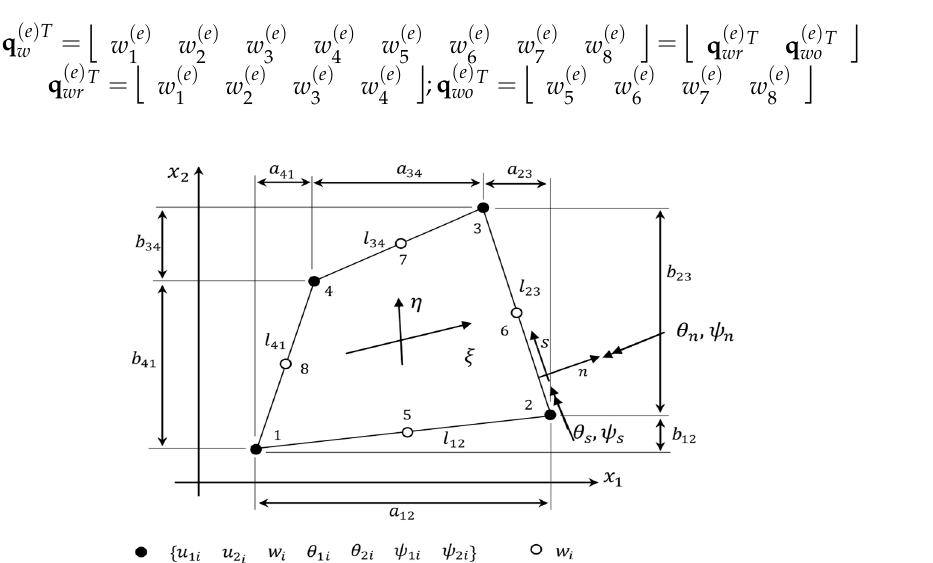
Figure 4. Eight-node virgin quadrilateral plate element. Geometry, physical co-ordinates ( x 1 , x 2 ), and natural co-ordinates ( ξ , η ). Boundary co-ordinate system ( n , s ). Definition of the parameters a ij and b ij entering in Equations (56) and (63) and the positive rotations ( θ 1 , θ 2 ) and ( θ n , θ s ).